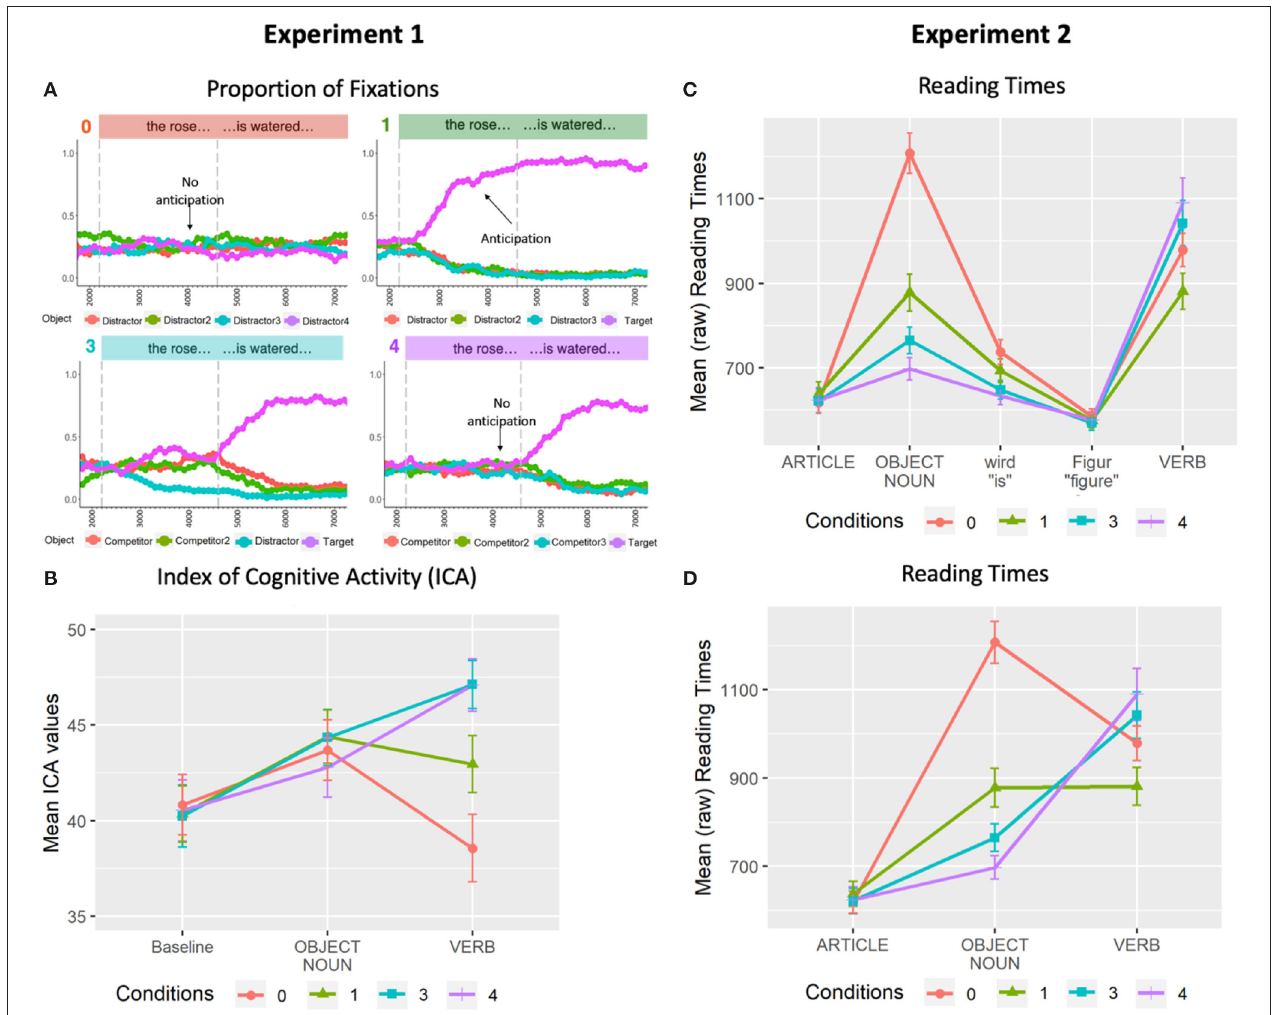
FIGURE 2 | Results from Experiment 1 (left) and Experiment 2 (right). (A) Proportion of fixations across averaged trial length in 100 ms bins in the 0-match, 1-match, 3-match, and 4-match conditions. (B) Mean ICA values for all four conditions. (C) Mean word-by-word (raw) reading times by condition across entire sentence. (D) Mean word-by-word (raw) reading times by condition for critical regions only. All error bars indicate 95% confidence